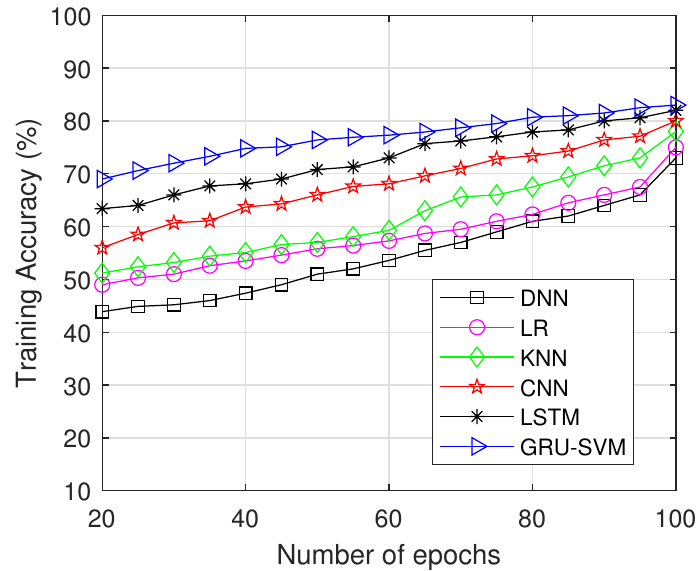
Figure 7. Training accuracy vs. Number of